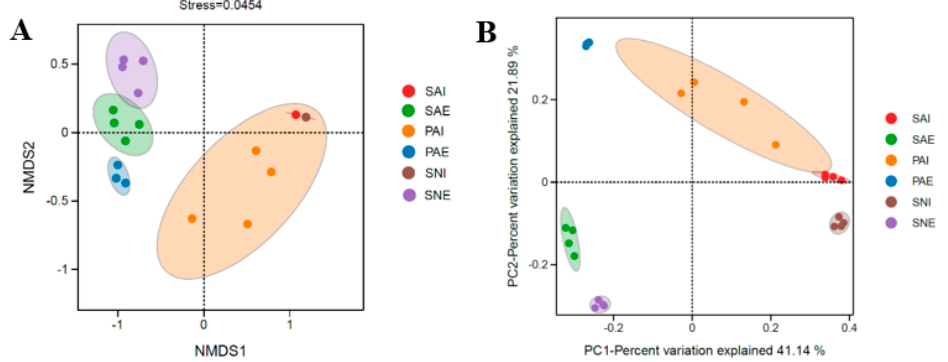
Figure 4. Nonmetric multidimensional scaling (NMDS) plot ( A ) and principal coordinates analysis (PCoA) plot ( B ) based on unweighted-unifrac distance showing the relatedness of the bacterial community composition between different samples. The gut contents and surrounding sediments of S. australe, P. arcuatum, and S. nudus, are, respectively, marked as SAI, PAI, SNI, SAE, PAE, and SNE.